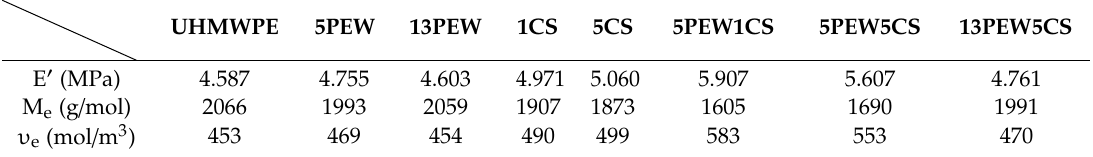
Figure 5. Storage modulus–temperature curves of UHMWPE with di ff erent contents of PEW and CS. Table 3. E (cid:48) , M e , and υ e values of UHMWPE with di ff erent contents of PEW and